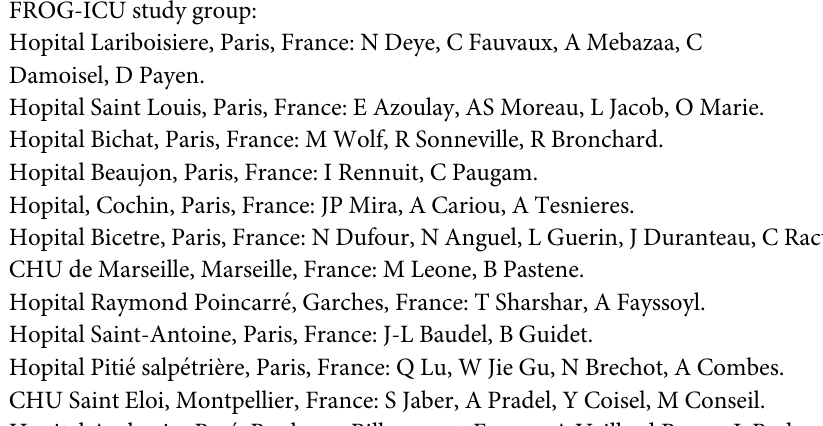
S1 Table. Patients matched in the Tracheostomy group and in the prolonged MV group without tracheostomy. SAPS: Simplified Acute Physiological Score. RBC: red blood cell. S2 Table. Long-term quality of life in patients with or without tracheostomy. During the first year of follow-up, there was no statistically significant difference regarding the Mental and Physical components of the SF-36 between both groups (p = 0.9 and 0.9 respectively). There is no statistically significant difference in IES-R, Anxiety symptoms (HADS scale) or Depression symptoms (HADS scale) between the 2 groups (respectively p = 0.9, 0.2, 0.5), or evolution over time (respectively p = 0.1, p = 0.4, p = 0.3). Two-way